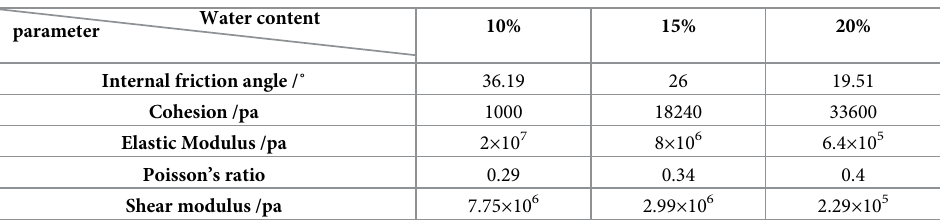
Table 1. Measurement results of soil